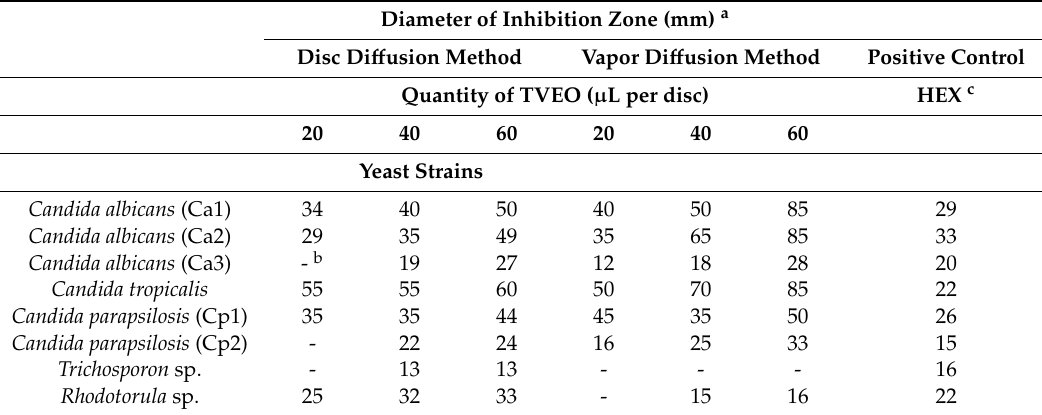
Table 2. Susceptibility of yeast strains to classic antiseptic and to Thymus vulgaris essential